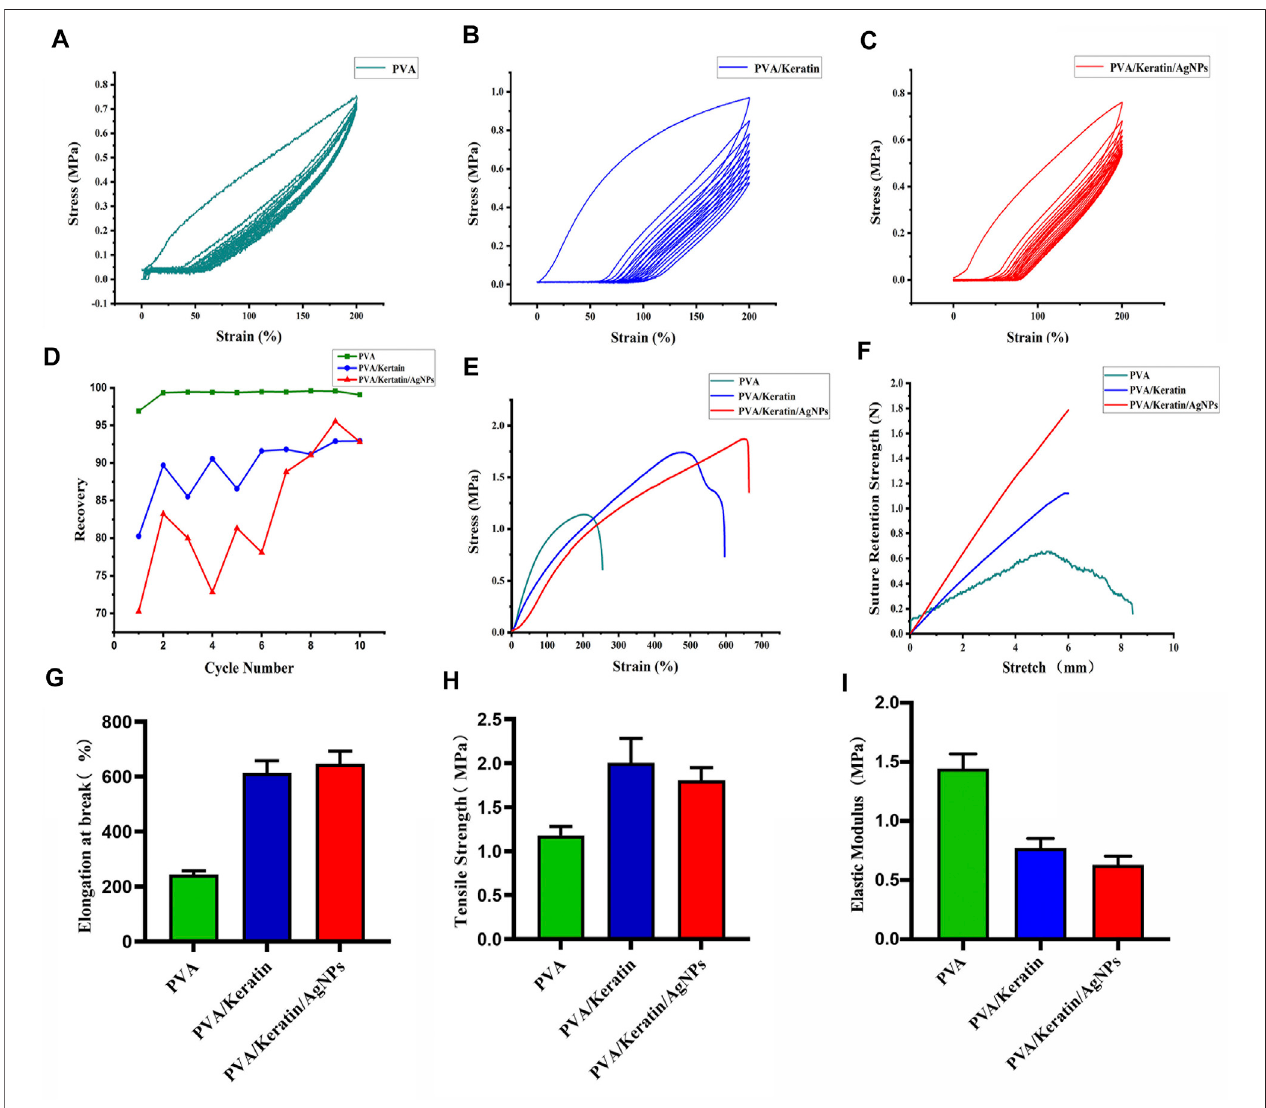
FIGURE3| Mechanicalpropertiesof fi lms. (A – C) DynamicstretchingtestofPVA,PVA/Keratin,andPVA/Keratin/AgNPs. (D) TheR%ofeachcycleforeach fi lm. (E) Tensile strain-stress curves of fi lms. (F) Suture retention strength of fi lms. (G – I) Elongation at break, tensile strength, and Elastic modulus of fi lms.